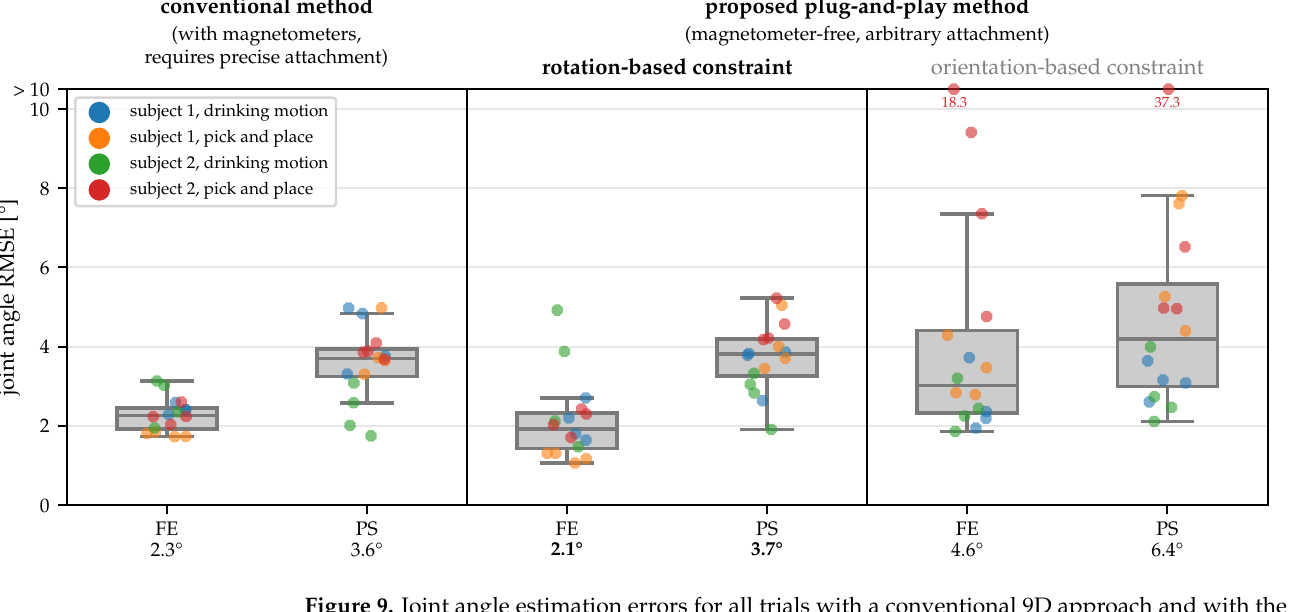
Figure 9. Joint angle estimation errors for all trials with a conventional 9D approach and with the proposed plug-and-play magnetometer-free methods, using OMC-based angles as ground truth. The numbers below the axis labels indicate the mean root mean square error (RMSE) for all 16 trials. The proposed method with the rotation-based constraint yields the same accuracy as the much more restrictive conventional 9D